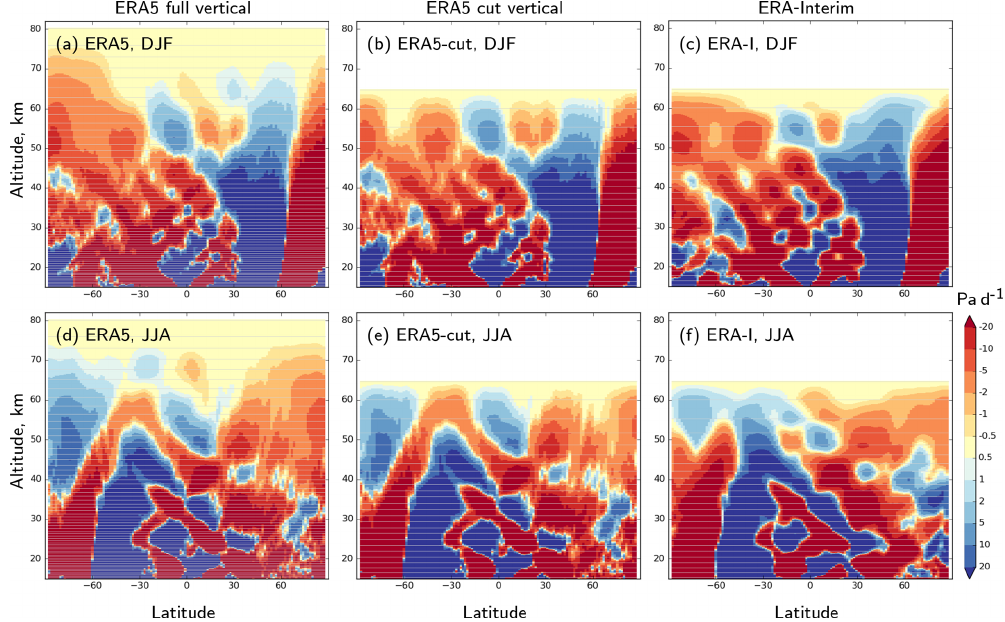
Figure 14. The seasonal and zonal-mean vertical air-mass fluxes diagnosed by SILAM from ERA5 and ERA-Interim fields for 2017 solstice seasons, expressed in terms of vertical velocity ω . Updraughts are red. The vertical-layer boundaries are shown with grey